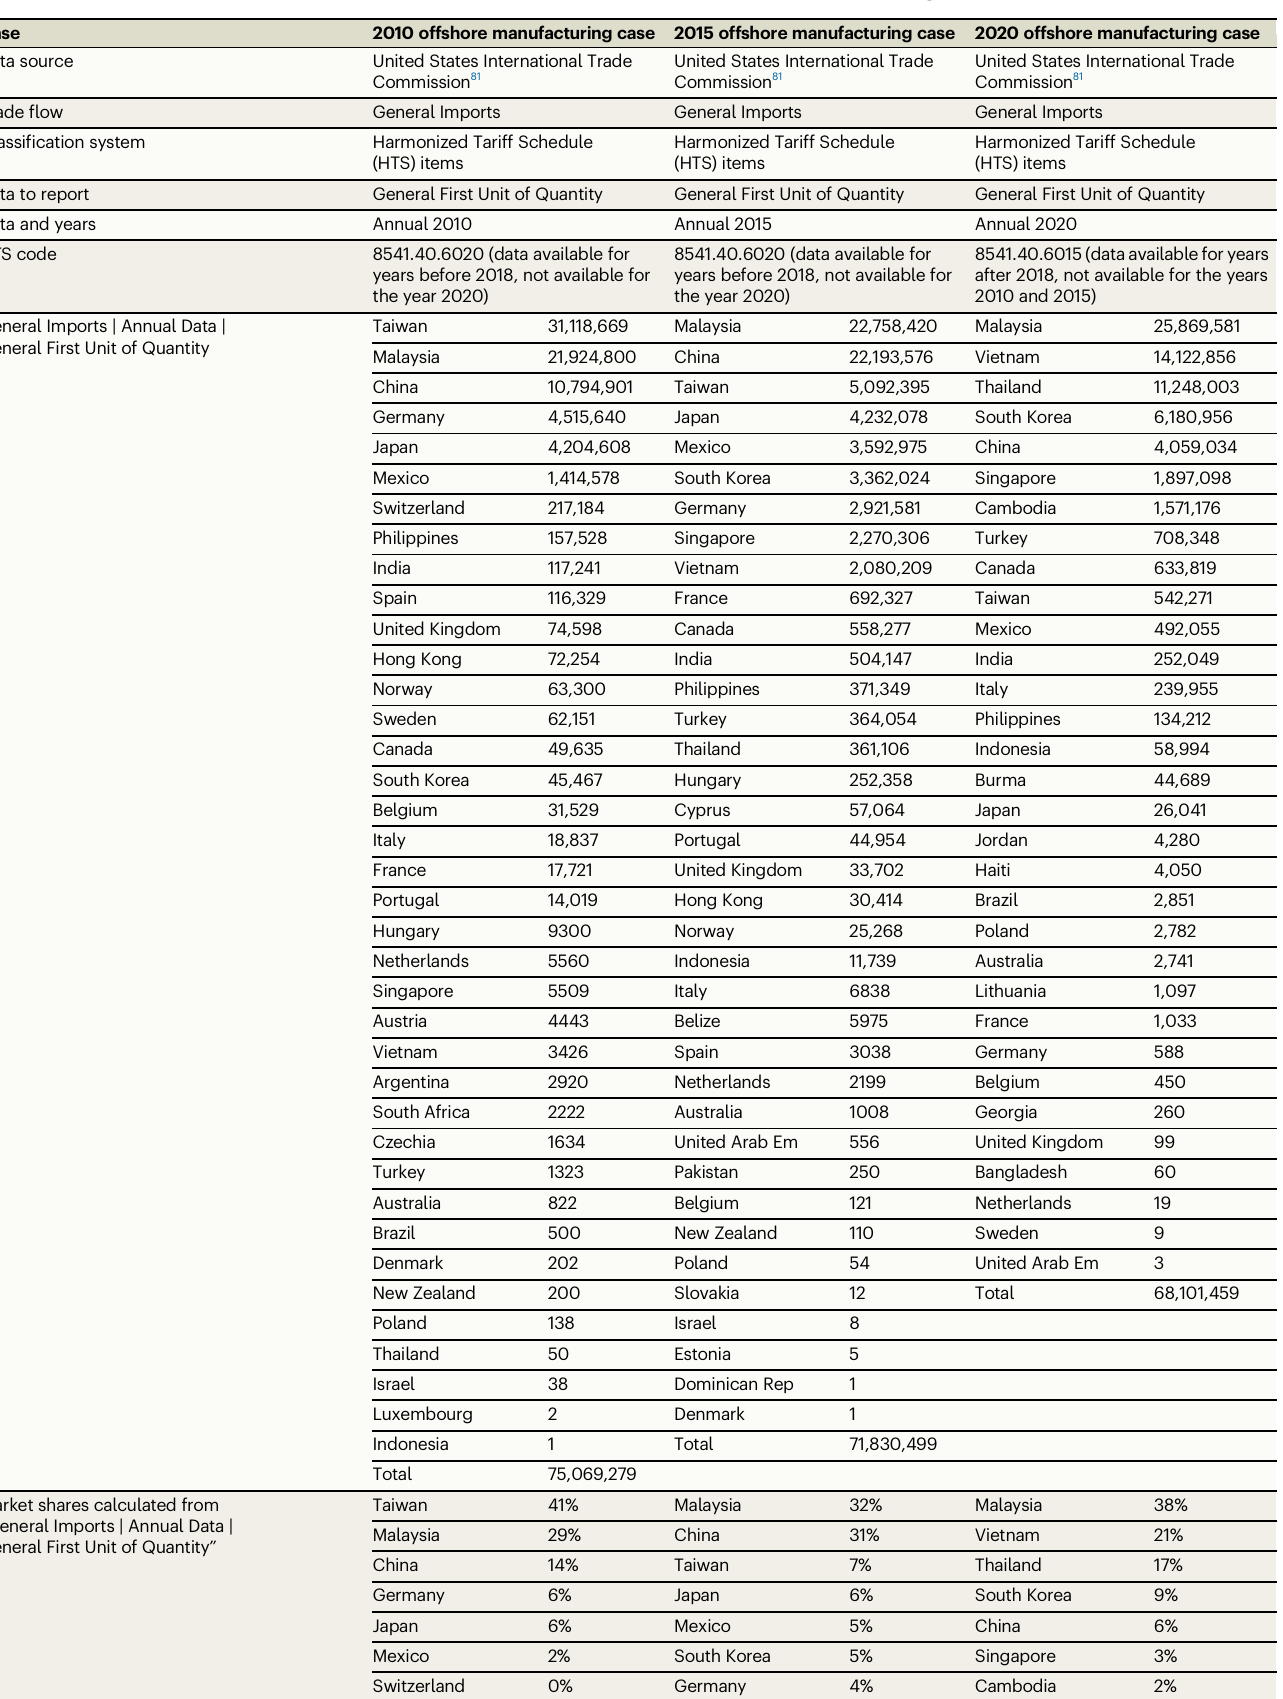
Table 1 | Supply chain structure ’ s data sources and assumptions for offshore manufacturing